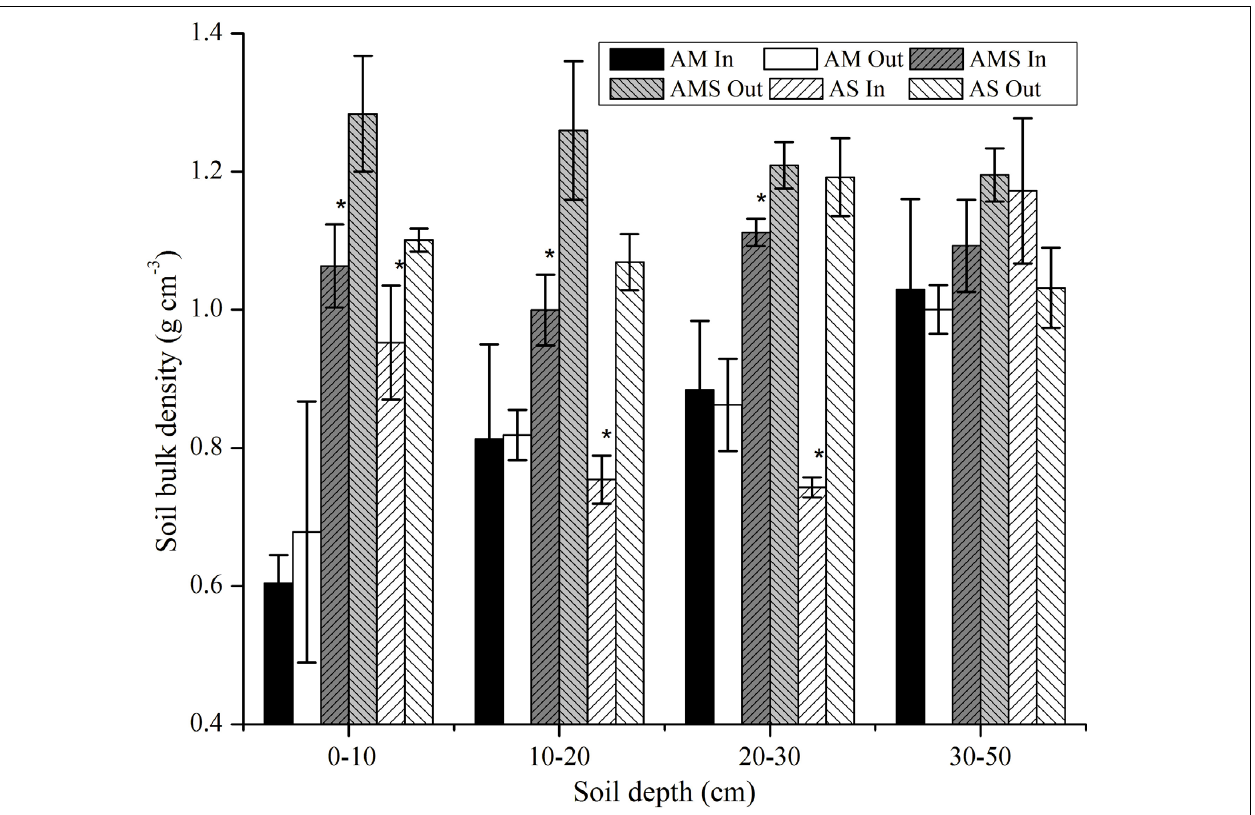
FIGURE 2 | Soil bulk density (BD) in the vertical direction between enclosed (In) and grazed (Out) sites with three vegetation types: alpine meadow (AM), alpine meadow steppe (AMS), and alpine steppe (AS). Error bars were the standard error of three replicates BD between enclosed and grazed sites. *Mean of the change of BD was significant at P <